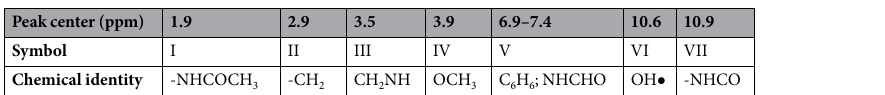
Table 2. Identification of 1 H NMR peaks of the molecular structure of melatonin after Co-60 gamma